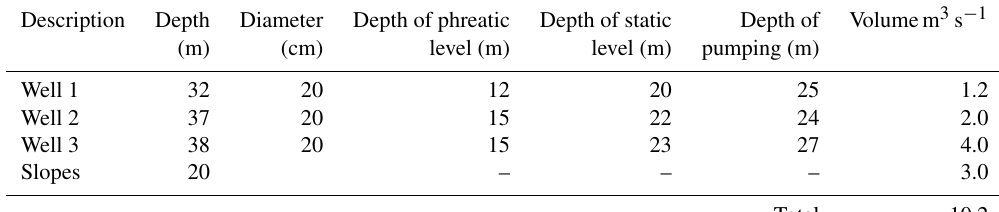
Table 1. Characteristics of wells and slopes.